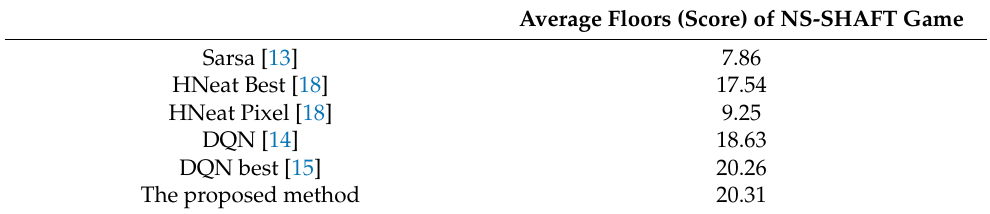
Table 17. The comparison with other methods by the average number of reached floors in the best 100 rounds of 2600